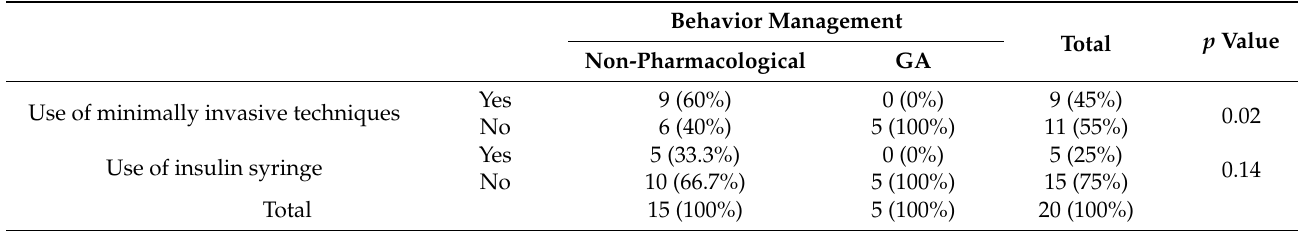
Table 5. The relationship between the use of minimally invasive treatment techniques and the use of an insulin syringe with non-pharmacological interventions or